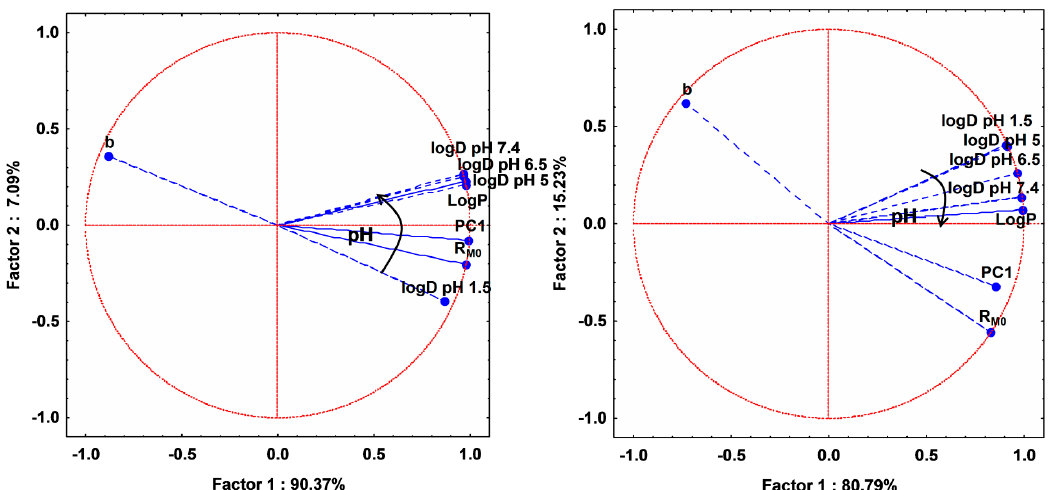
Figure 5. Loadings (circle correlation) for the experimental lipophilicity indices (R M0 , PC1, b) and computed (LogD and LogP—calculated by the equally weighted calculation algorithm combining the three methods described in the Experimental Section) lipophilicity indices for compounds in group A ( left ) and for compounds in groups B and C ( right ).